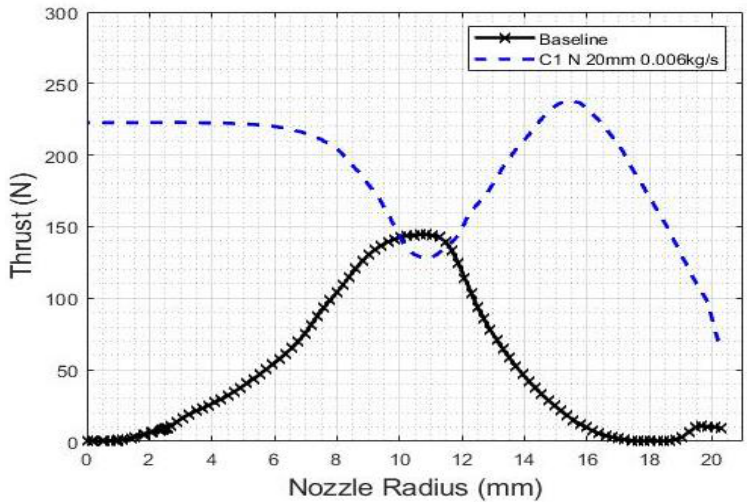
Figure 26. Thrust vs. nozzle radius.